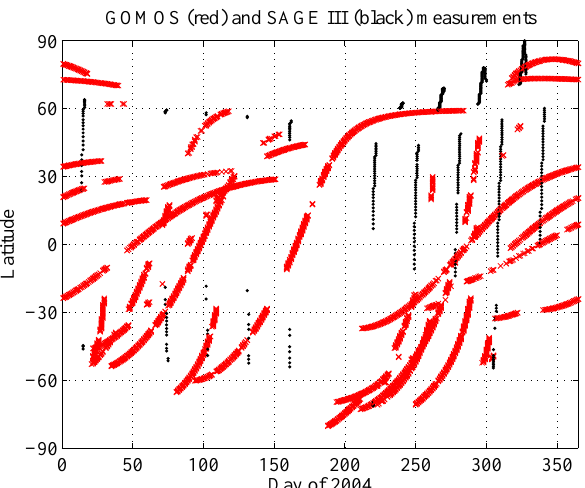
Fig. 2. GOMOS (red) and SAGE III (black) measurements in the year 2004. The GOMOS data have been screened, so that the solar zenith angle is higher than 107 ◦ and the stars used are brighter than 1.9 magnitude and cooler than 15000K. The SAGE III data have been screened, so that the solar zenith angle is higher than 107 ◦